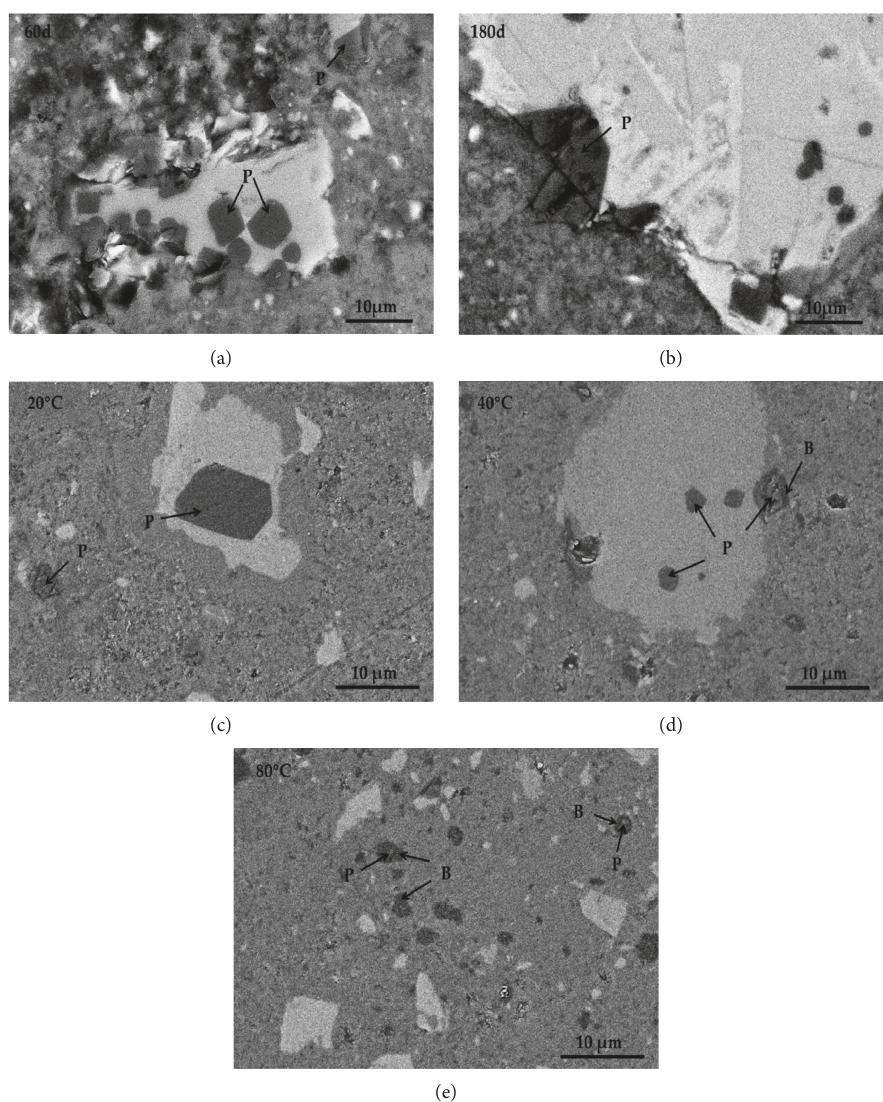
Figure 5: BSEM images of cement paste with 4.00 μ m periclase particles cured at different temperatures for 60, 180, and 240 days. (a) Curing at 20 ° C for 60 days; (b) curing at 20 ° C for 180 days; (c) curing at 20 ° C for 240 days; (d) curing at 40 ° C for 240 days; (e) curing at 80 ° C for 240